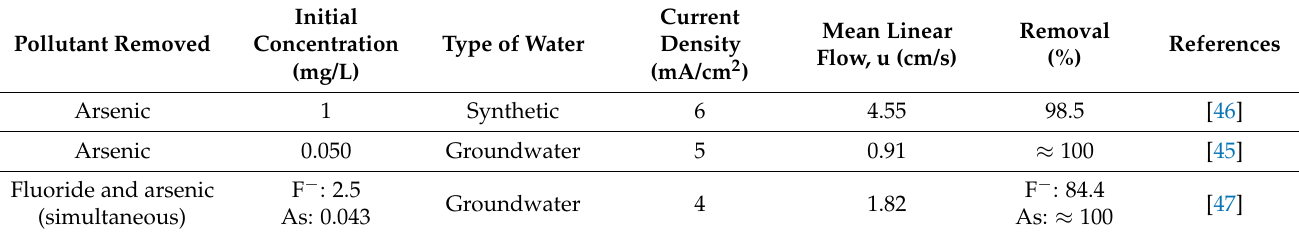
Table 1. EC processes comparison carried out in the same filter-press reactor.